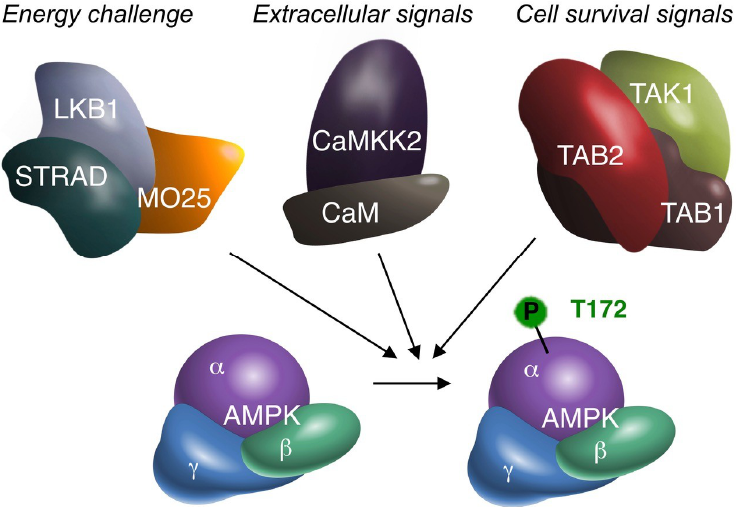
Figure 1. The three alternative AMPK kinases. Biochemical (cell-free), cell biological (in vitro) and animal (in vivo) experimentation suggest that TAK1 can activate AMPKα by phosphorylation of the critical T172 residue. Summative evidence therefore supports TAK1 as an additional AMPK upstream kinase, besides LKB1 and CaMKK2. AMPK may receive (simultaneous) activation from all three upstream kinases. The original signal leading to AMPK activation may differ per upstream kinase, as suggested above. All four kinases are depicted with their accessory subunits, as functional protein complexes. The requirement of TAB1/TAB2/TAB3 for AMPK activation has not been fully elucidated. However, to date TAB1 and/or TAB2 are the most likely candidates. TAB1 may also bind to AMPK independent of TAK1 [30]. MO25: mouse protein 25; STRAD: STE20-related kinase adapter protein; CaM: Calmodulin.